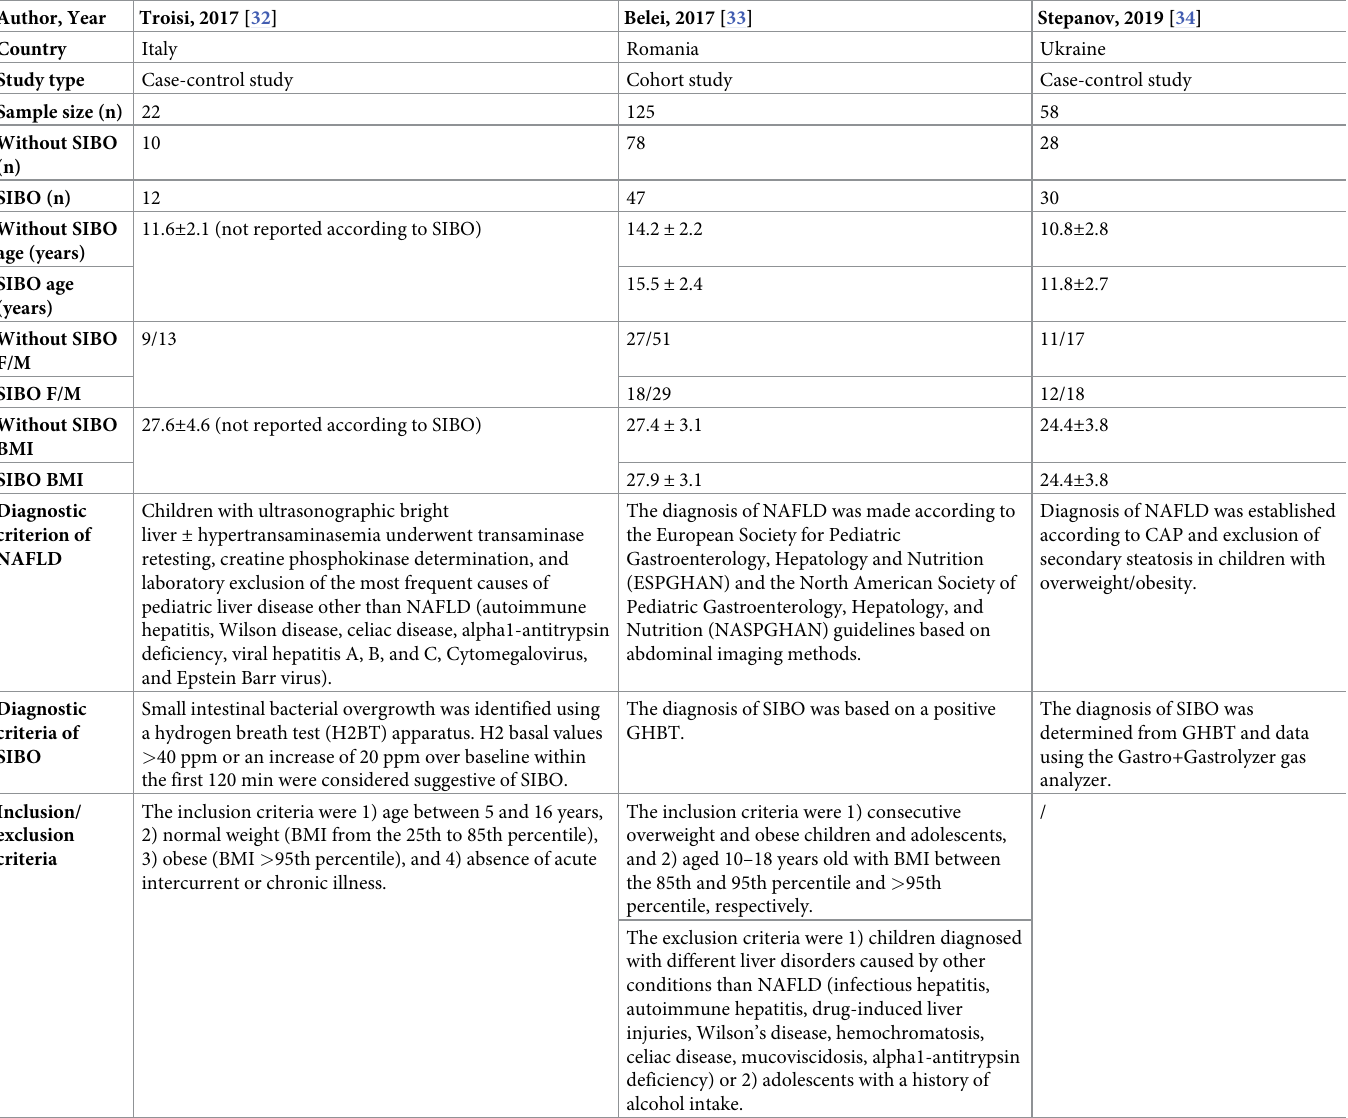
Table 1. Characteristics of the included